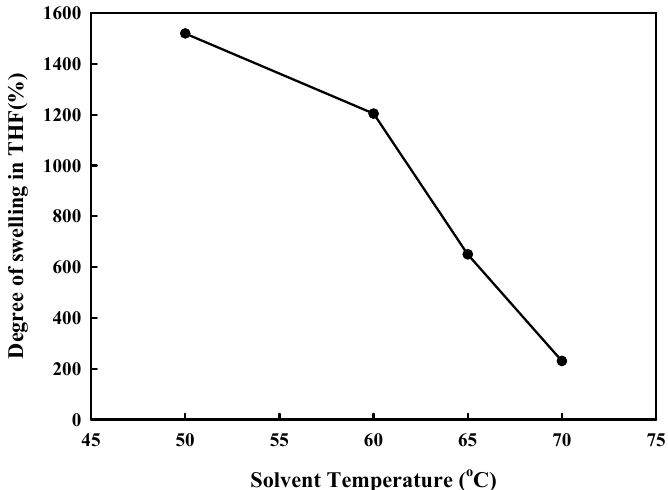
Figure 7. Effect of solvent temperature on the degree of swelling of PA6/PK(90/10) blend with ADR in THF for 100 min.